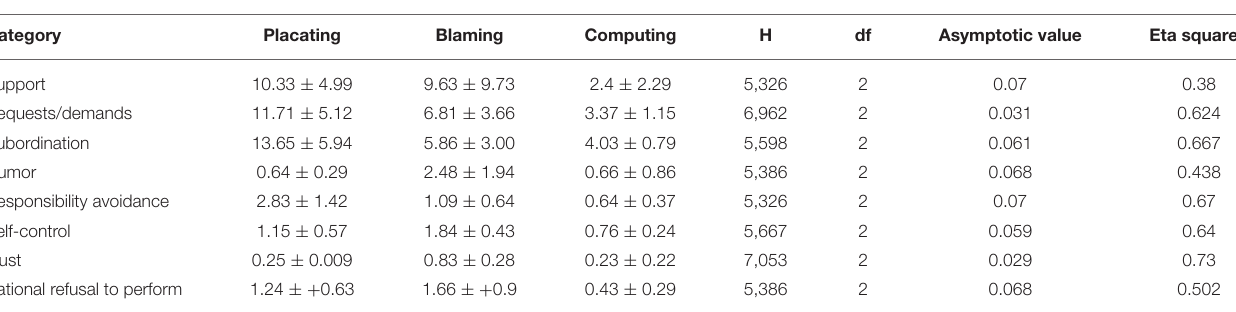
TABLE 3 | Kruskal–Wallis one-way ANOVA, grouping variable: styles.